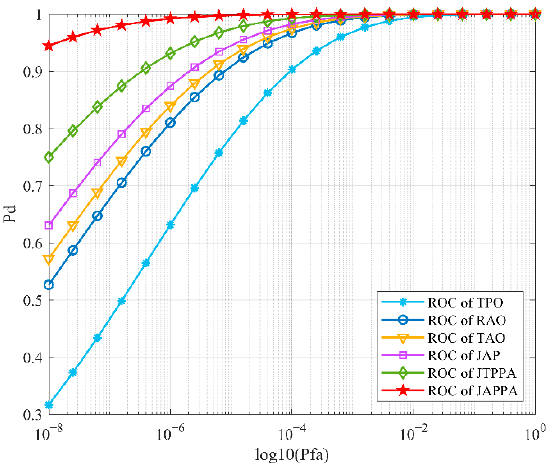
Figure 7. Average ROC curves for power allocation method.